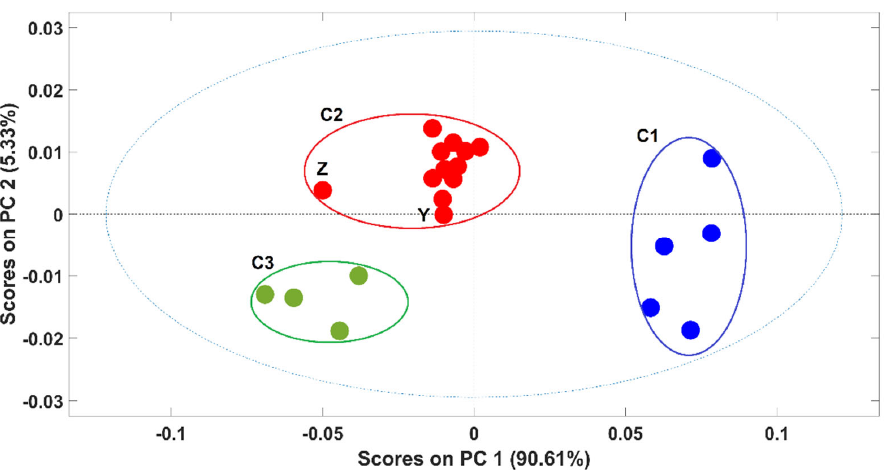
Figure 3. Scores plot of the first two principal components (PCs) of the PCA model. Legend: • arabica; • ≤ 10% of adulterants; • >10% of adulterants. Samples Z and Y contain 10% of adulterants (5% of rice + 5% of coffee husks and 10% of rice, respectively).